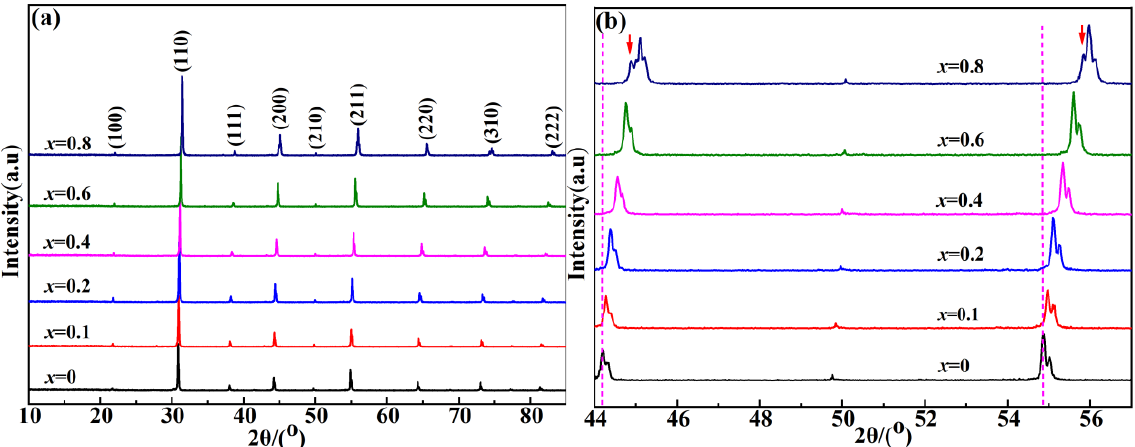
Figure 2. ( a ) XRD patterns of BSZN ceramics and ( b ) XRD patterns of BSZN ceramics in the 2 θ range 44–57 ◦